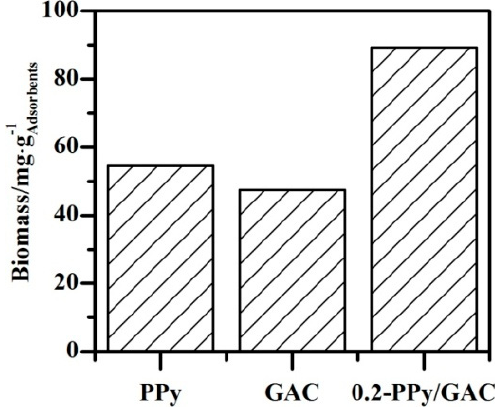
Figure 6. Biomass concentration of three separate columns with different adsorbents.